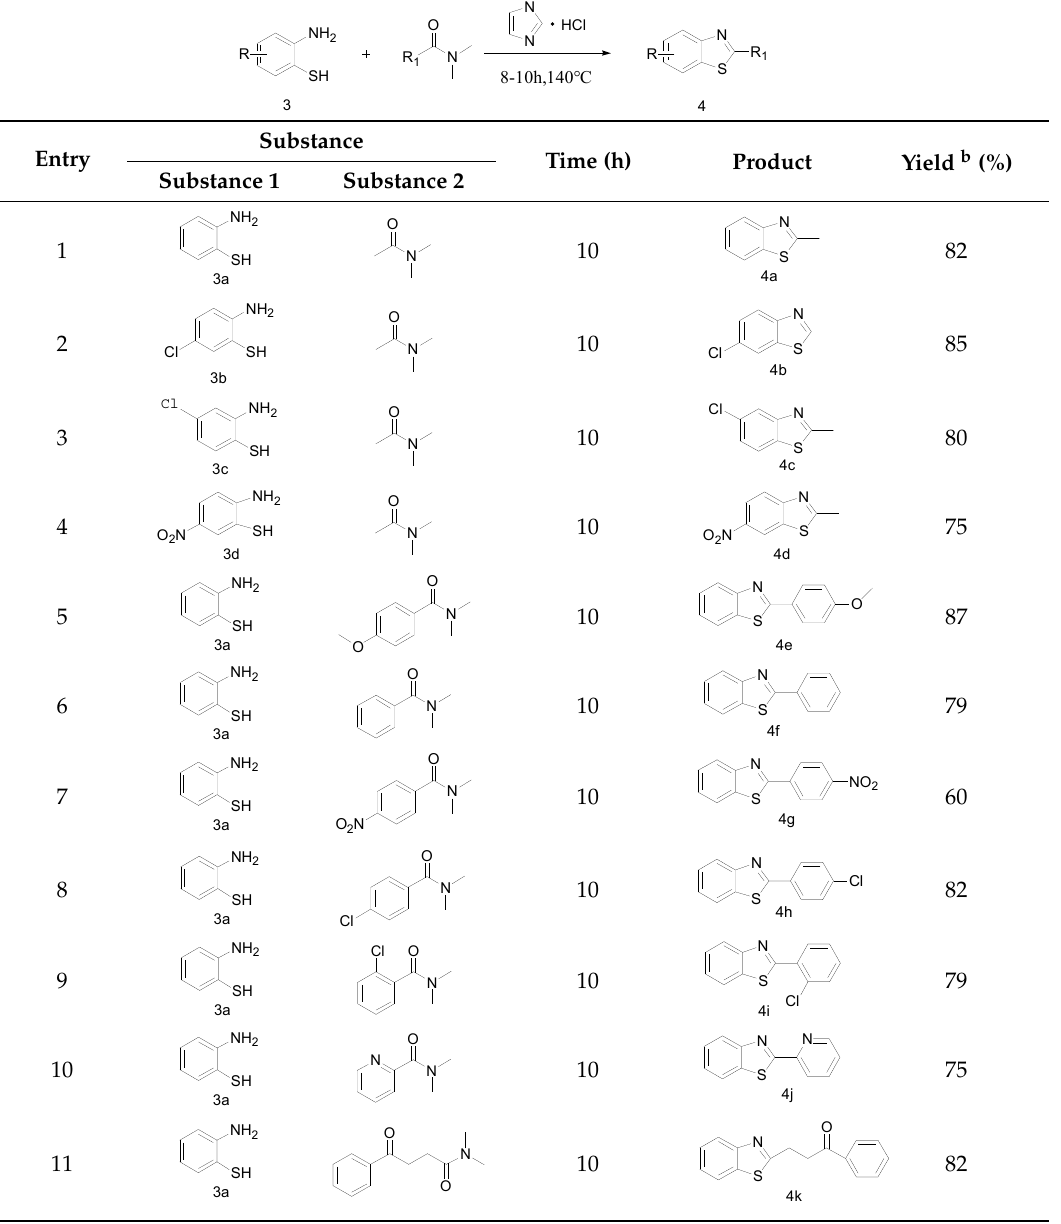
Table 4. Substrate scope with respect to substituted 2-aminothiophenols a.